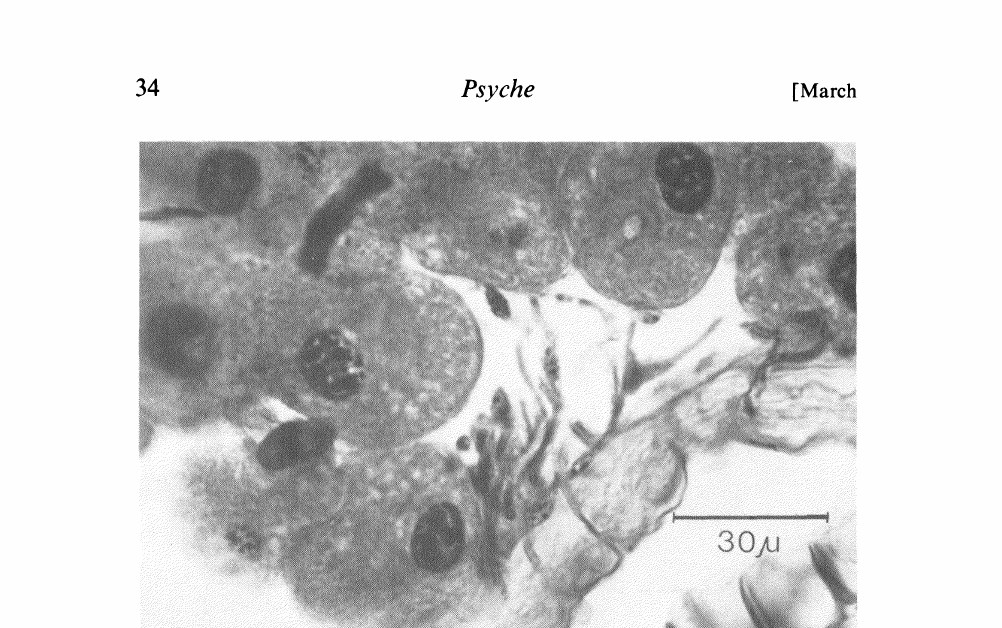
Figure 2. Sagittal section through the tergal gland complex, showing the chan- nels that open through the intersegmental membrane. ants were fixed in alcoholic Bouin (Dubosq Brasil), embedded in Methyl Methacrylate and sectioned 8 u with a Jung